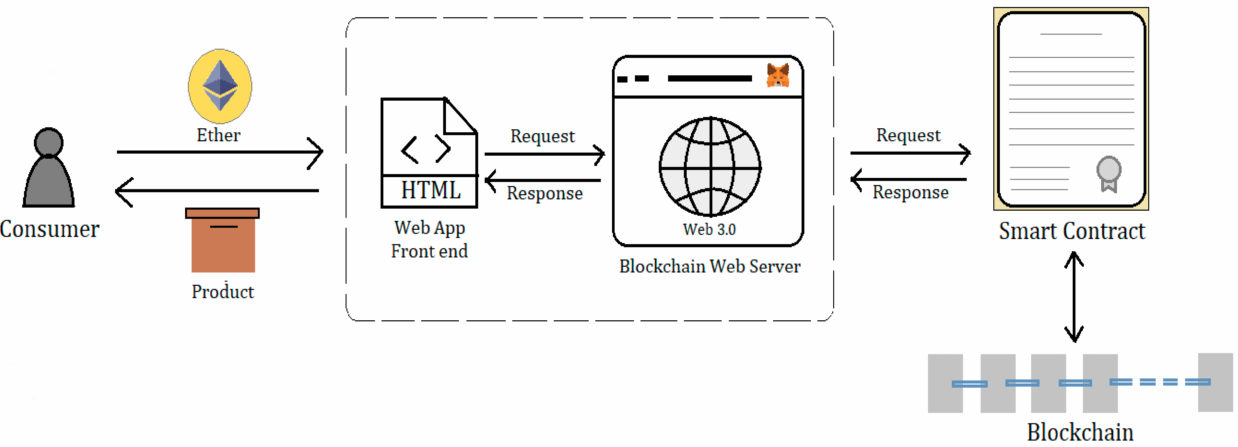
Figure 7. Blockchain web app